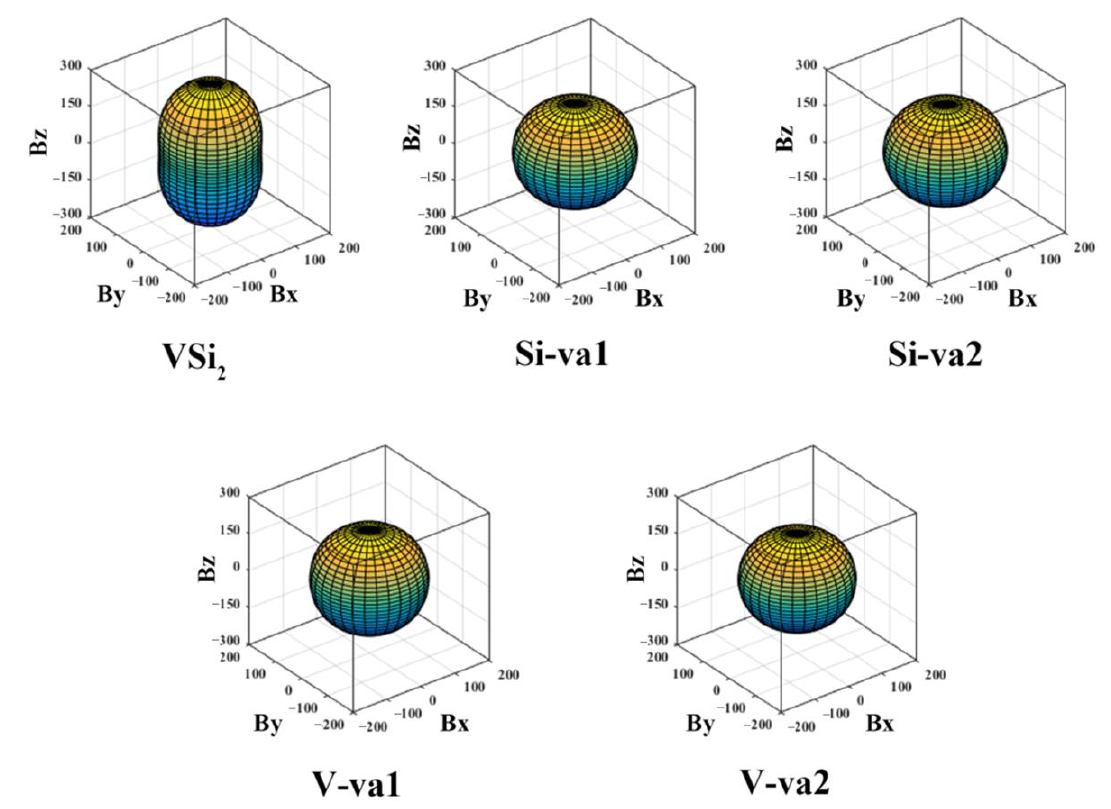
Figure 3. Surface constructions of bulk moduli of C11 b -VSi 2 .